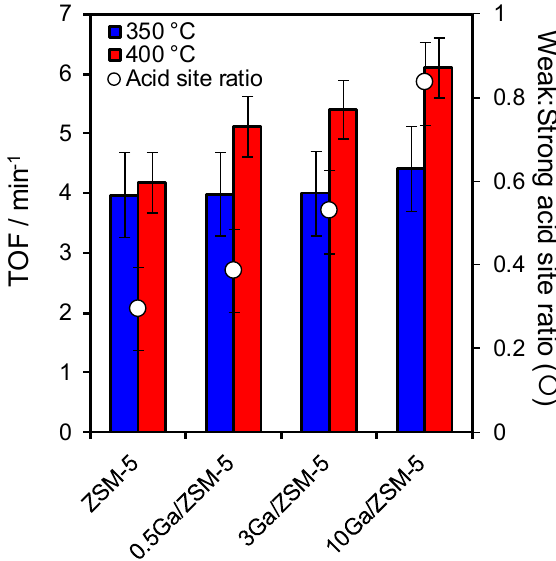
Figure 5. Turnover frequencies (TOFs) for acetic acid ketonisation over xGa / HZSM-5 and corresponding weak:strong acid site ratio. Reaction conditions: 200 mg catalyst, 0.2 mL · min − 1 acetic acid, 50 mL · min − 1 N 2 , 1 bar.